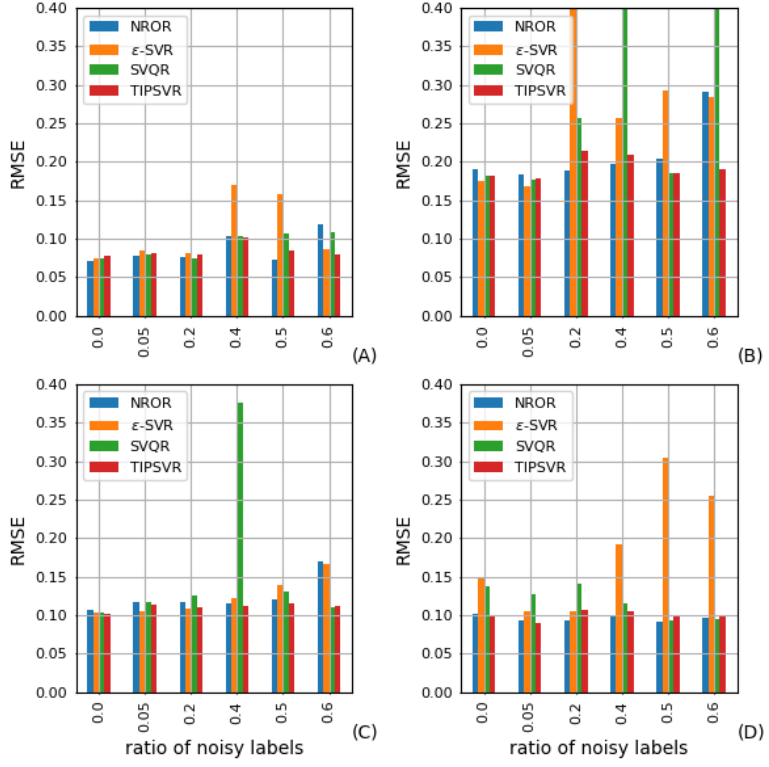
Figure 8. RMSE for noise of heteroscedasticity on ( A ) CCPP, ( B ) DB, ( C ) EGSSD, ( D )